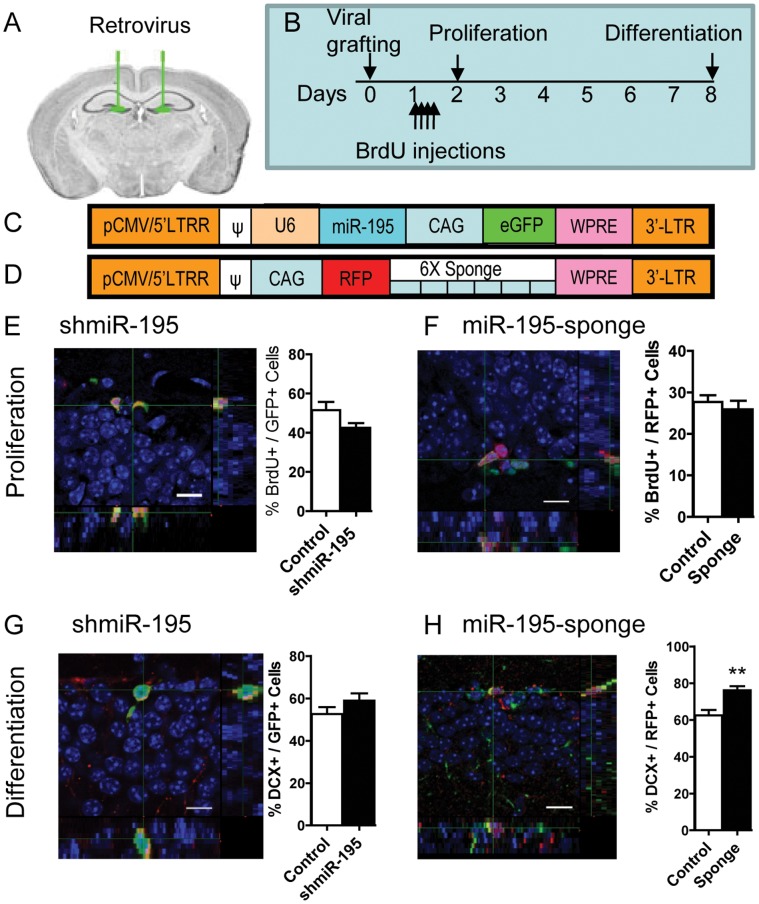
miR-195 modulates differentiation of adult NSCs in vivo.(A, B) Experimental scheme for assessing aNSC proliferation and early stage differentiation in adult mice after retrovirus grafting. The experimental and control viruses were grafted on either side of the same animals. (C). Schematic drawing of the retroviral vector used for expressing miR-195 or sh-NC. Sh-miR-195 was expressed as a short hairpin driven by U6 RNA polymerase III promoter, while GFP was expressed driven by a chicken actin (CAG) promoter. (D). Schematic drawing of the retroviral vector used for expressing miR-195-sponge. The 6 tandem repeats of miR-195-sponge were inserted in the 3′ region of RFP, therefore the expression of both RFP and miR-195-sponge were driven by the CAG promoter. (E-H) Left panels show representative 3D Z-stack images of BrdU+GFP+ (E), BrdU+RFP+ (F), DCX+GFP+ (G), and DCX+RFP+ (H) cells, used for quantification. Right panels shows quantification of retrovirus-infected cells that have incorporated BrdU (E, F) or differentiated into neurons (G, H). (E, F) Compared with control retrovirus-infected cells, neither shmiR-195 retrovirus (E, control n = 6, shmiR-195 n = 4, p = 0.14), nor miR-195-sponge virus (F, control n = 4, sponge n = 4, p = 0.52), had significant effect on BrdU incorporation of infected aNSCs. (G–H) although shmiR-195 retrovirus did not alter neuronal differentiation (G, control n = 6, shmiR-195 n = 6, p = 0.22), a higher percentage of miR-195-sponge retrovirus-infected cells was positive for DCX (H, control n = 4, sponge n = 5, p = 0.007). Data are presented as mean ± SEM; statistics were done using student t-test **, p<0.01.